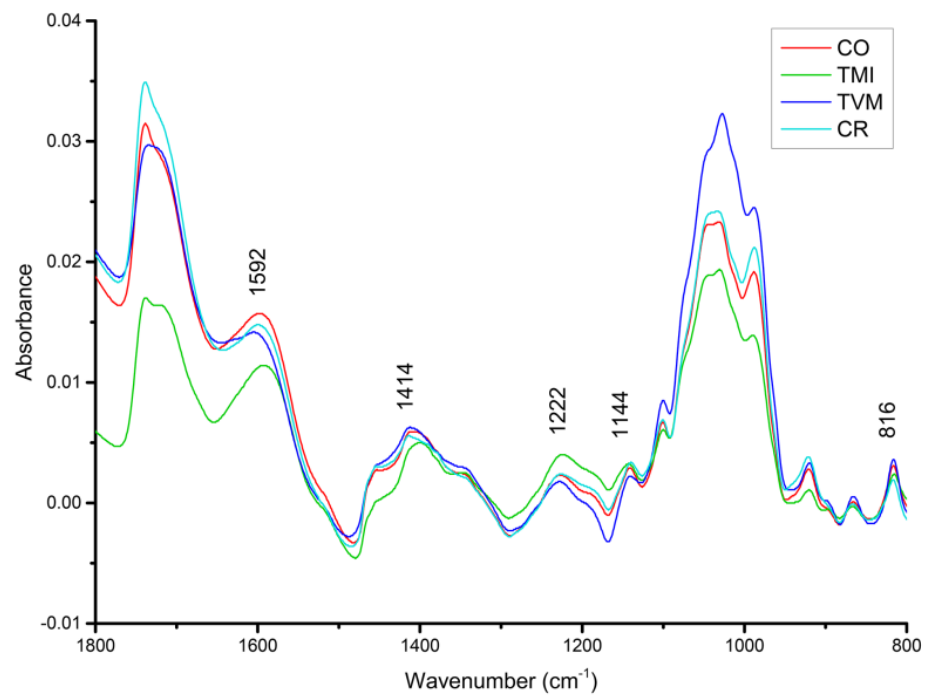
Figure 2. Mean FTIR spectra (1800–800 cm − 1 ) of the tamarillo extracts presently studied. TMI, imported red tamarillo; TVM, Mealhada red tamarillo; CR, Botanical Garden red tamarillo; CO, Botanical Garden orange tamarillo.